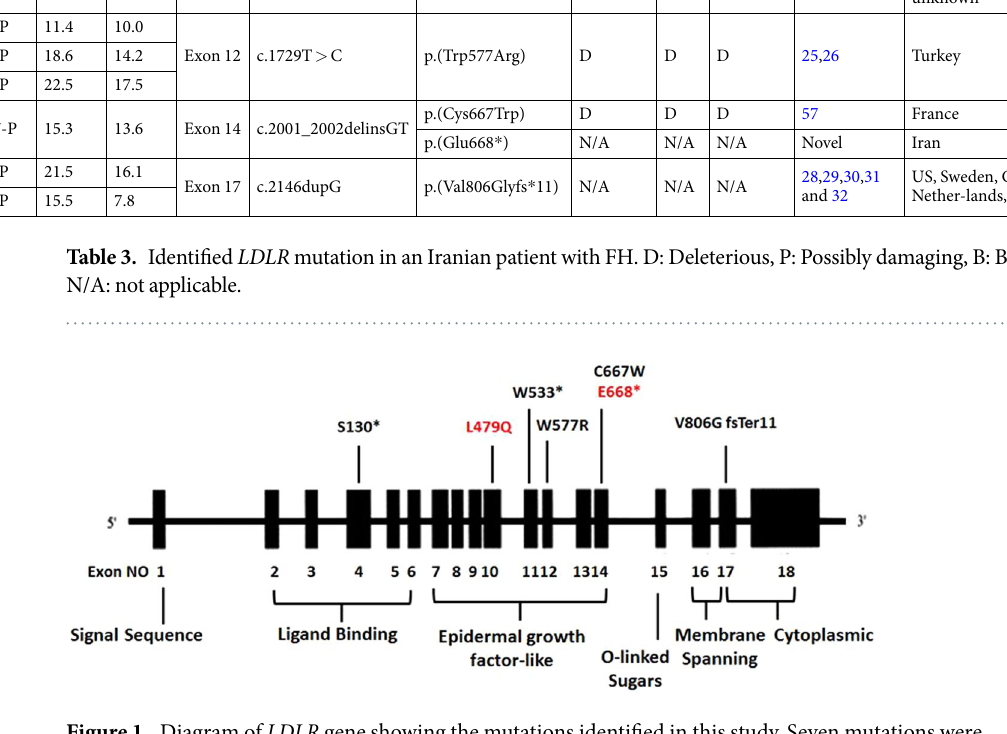
Figure 1. Diagram of LDLR gene showing the mutations identified in this study. Seven mutations were identified in this study: two novel mutations are indicated in red. Exons are shown as vertical boxes and introns as the lines connecting